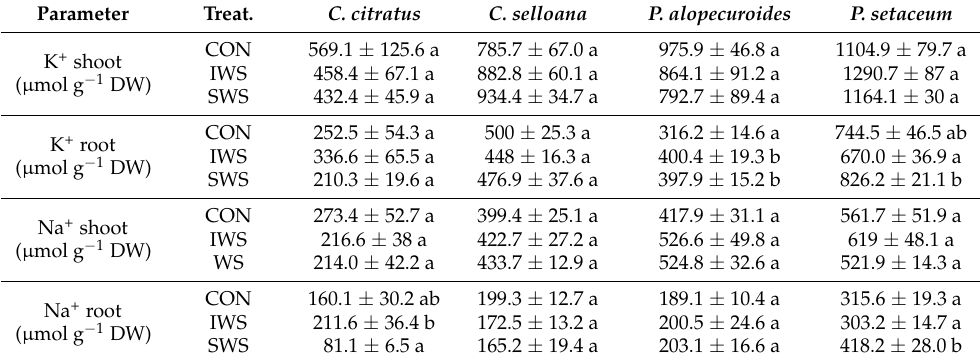
Table 5. Effect of the water stress treatments on sodium (Na + ) and potassium (K + ) root and shoot contents in the four investigated species. Values are means ± SE ( n = 5). Different lowercase letters indicate significant differences between treatments, for each species and measured variable, according to the Tukey test ( p < 0.05).